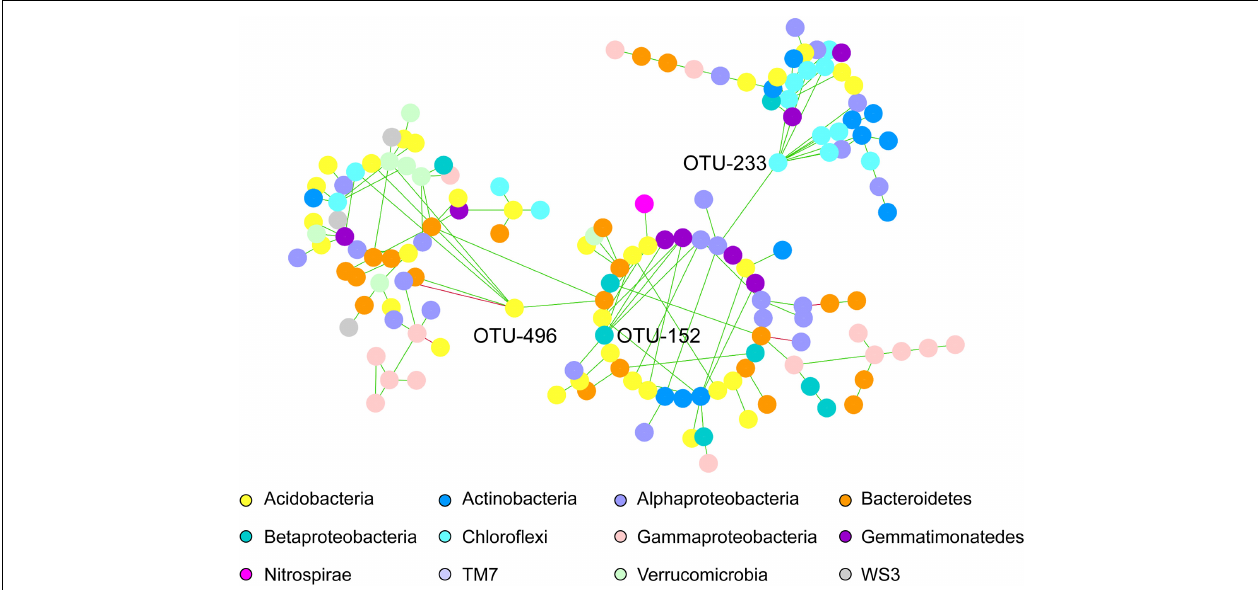
FIGURE 3 | Co-occurring bacterial network of common OTUs belonging to intercropped wheat and pea rhizosphere. Each network node (individual circle) represents an OTU. Network edges are represented as straight lines connecting the nodes and indicate significant co-occurrences based on partial correlation obtained from a Poisson Log Normal model ( r > | 0.03|, p < 0.05, n = 30 iterations); green for positives and red for negative co-occurrence. OTU-496, OTU-152 and OTU-233 have been identified as keystone